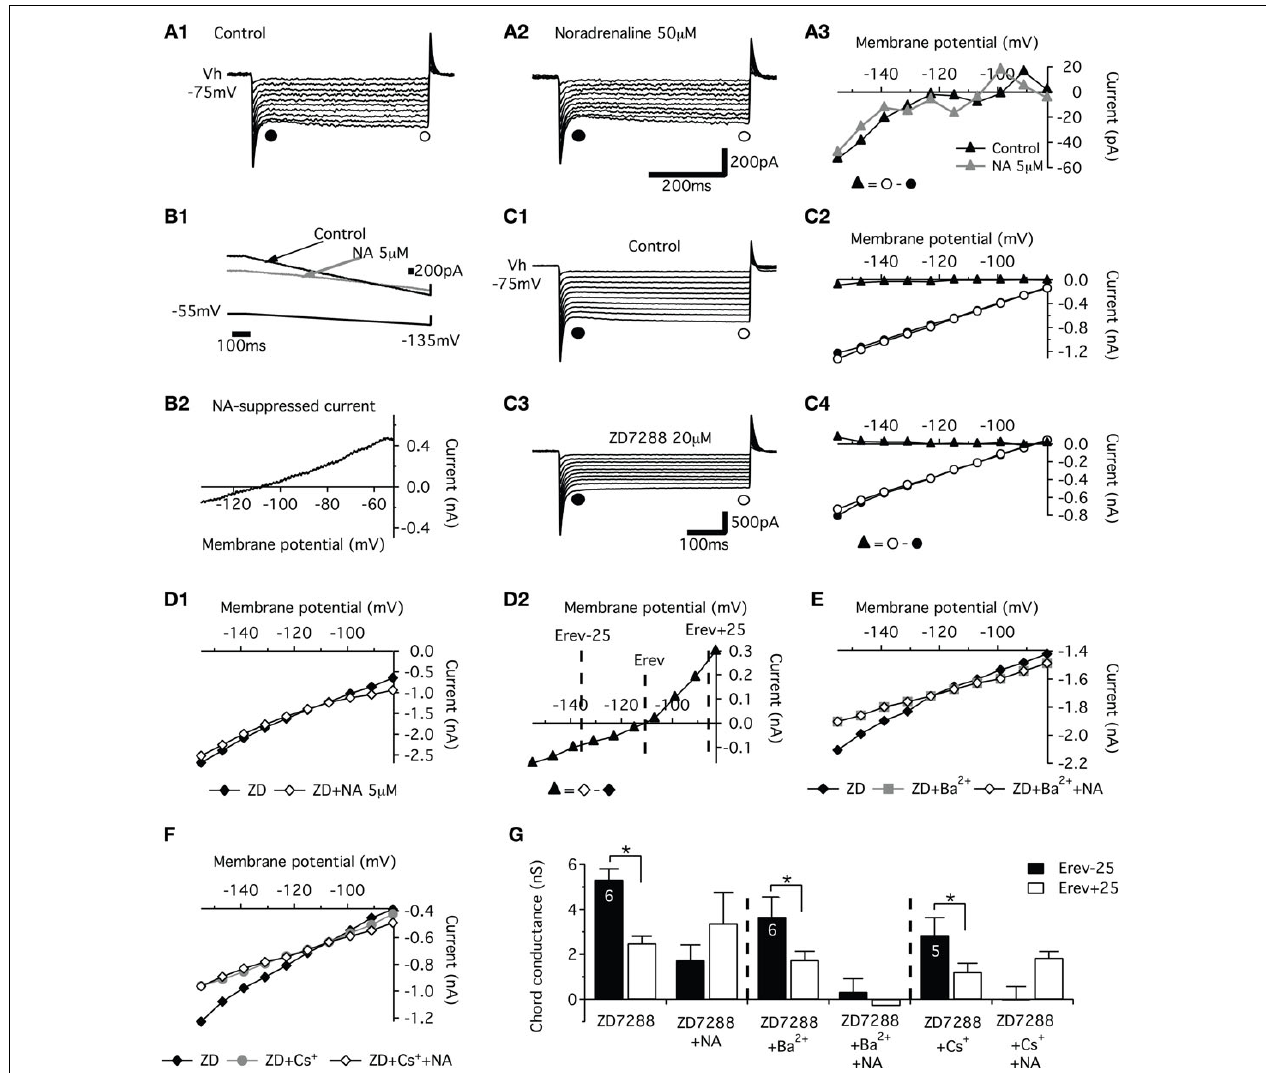
FIGURE 3 | Effects of noradrenaline (NA) on I and K currents. (A) Sample H IR current traces obtained in response to a family of hyperpolarizing voltage steps, under control conditions (A1) and in the presence of NA (A2) . The current–voltage (I–V) relationships for I ( (cid:99) ) computed from the traces in H (A1,A2) and obtained by subtracting the instantaneous current ( (cid:122) ) from the steady state ( (cid:123) ) current (A3) . (B) I–V relationships during voltage ramps in control saline (black line) and in the presence of NA (grey trace) (B1) . The NA- suppressed current was isolated by subtracting currents of I–V relationships obtained in the presence of NA from that obtained in control conditions (B2) . (C) Current responses evoked by a series of voltage steps (10 steps, − 8 mV increment) from a holding potential of − 75 mV (V ) in control conditions (C1) H and in the presence of 20 µM ZD7288 (C3) . In the corresponding I–V relationships (C2,C4) , I I–V relationships ( (cid:99) ) computed from the traces in C1 H and C3 results and obtained from subtracting the instantaneous current ( (cid:122)